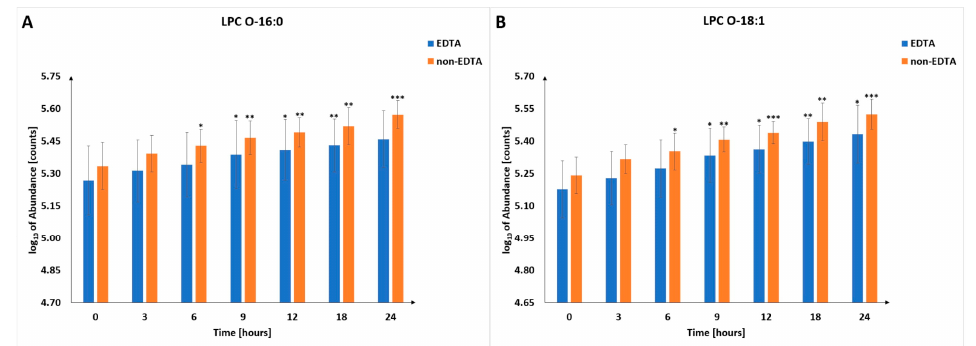
Figure 4. Changes in the level of selected lysophosphatidylcholines in different postmortem time intervals. Panel ( A ) shows the trajectory for LPC O-16:0, while panel ( B ) shows LPC O-18:1. *— p -value < 0.05, **— p -value < 0.01, ***— p -value < 0.001.